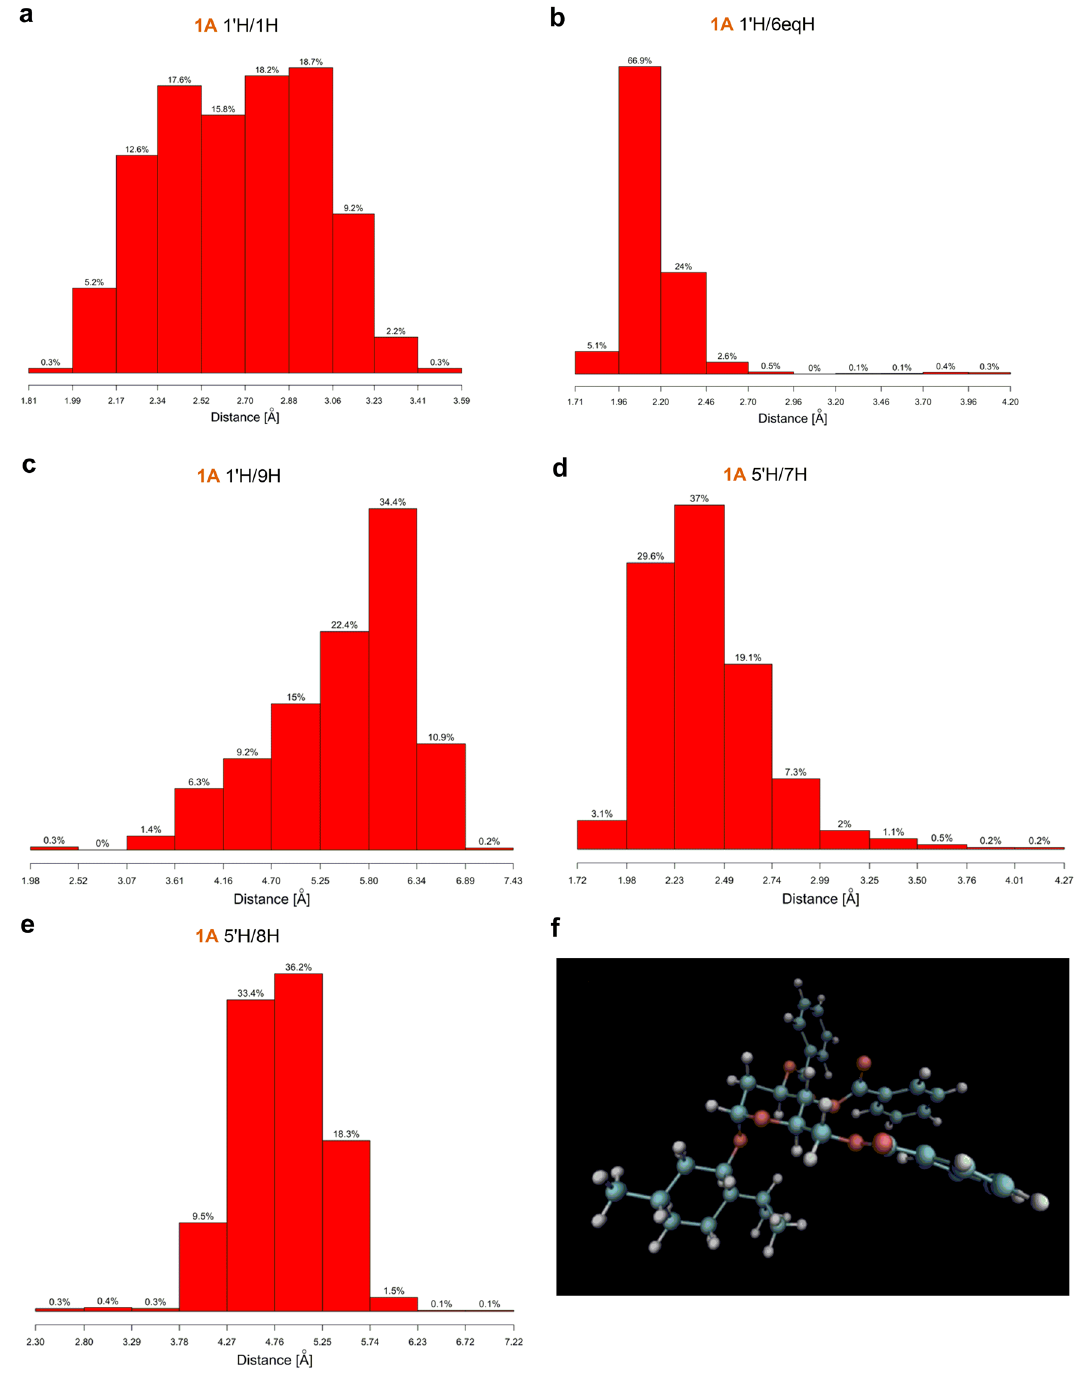
Figure 12. Compound 1A : histograms of ( a ) 1’H / 1H ( b ) 1’H / 6eqH ( c ) 1’H / 9H ( d ) 5’H / 7H ( e) 5’H / 8H distances and ( f )